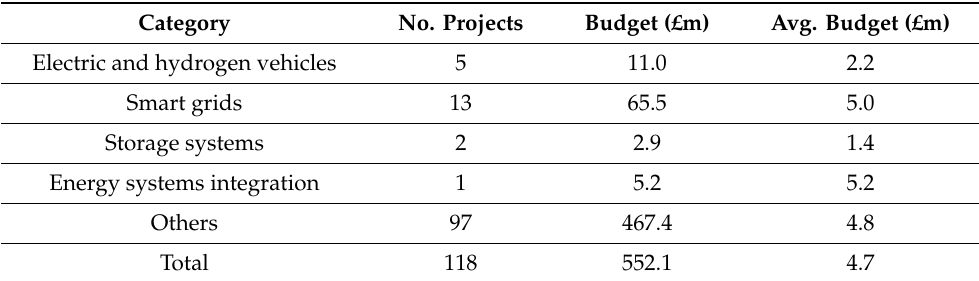
Table 1. Classification of the UK’s Network Innovation Competition (NIC) and Network Innovation Allowance (NIA) projects (above £1 million